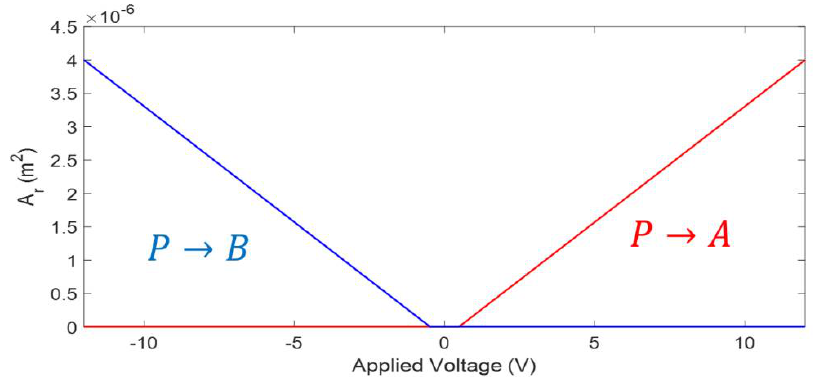
Figure 6. Changes in the input valve cross-sectional area with the applied voltage.